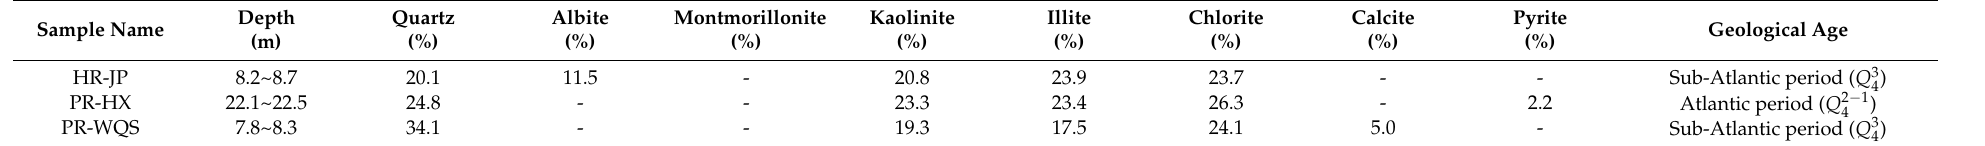
Table 2. The mass ratio of sedimentary mineral composition in marine clay of two deltas in the South China Sea.